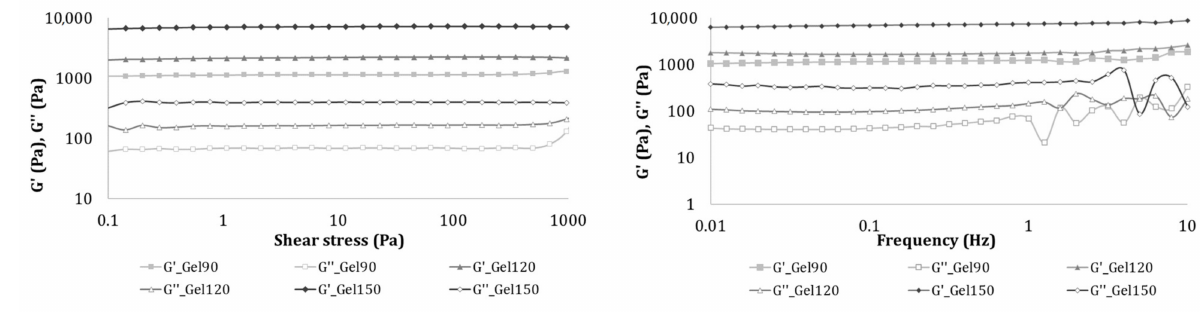
Figure 2. Amplitude stress sweep tests at 1 Hz ( left ) and frequency sweep tests ( right ) for the three gels at 25 ◦